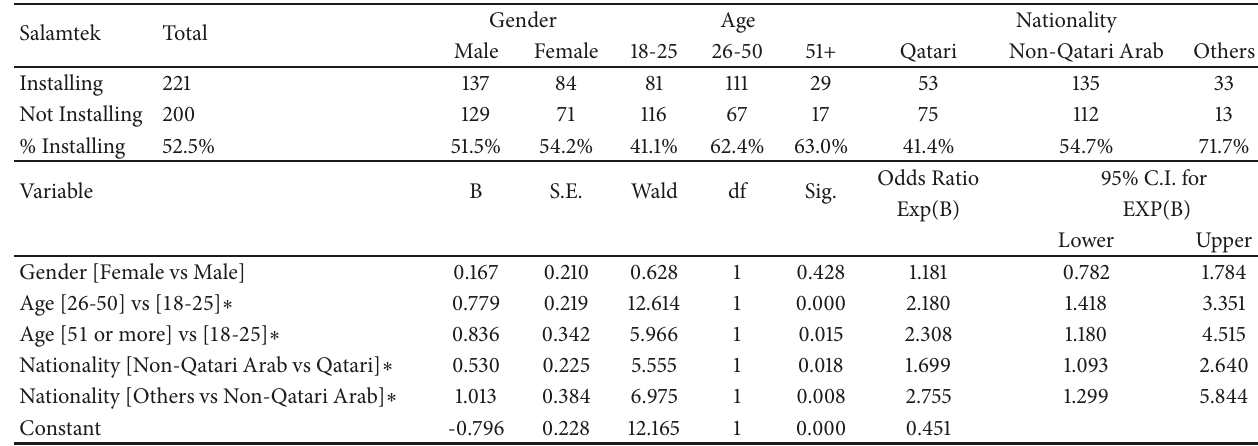
Table 4: Drivers’ choice of installing/not installing Salamtek and logistic model